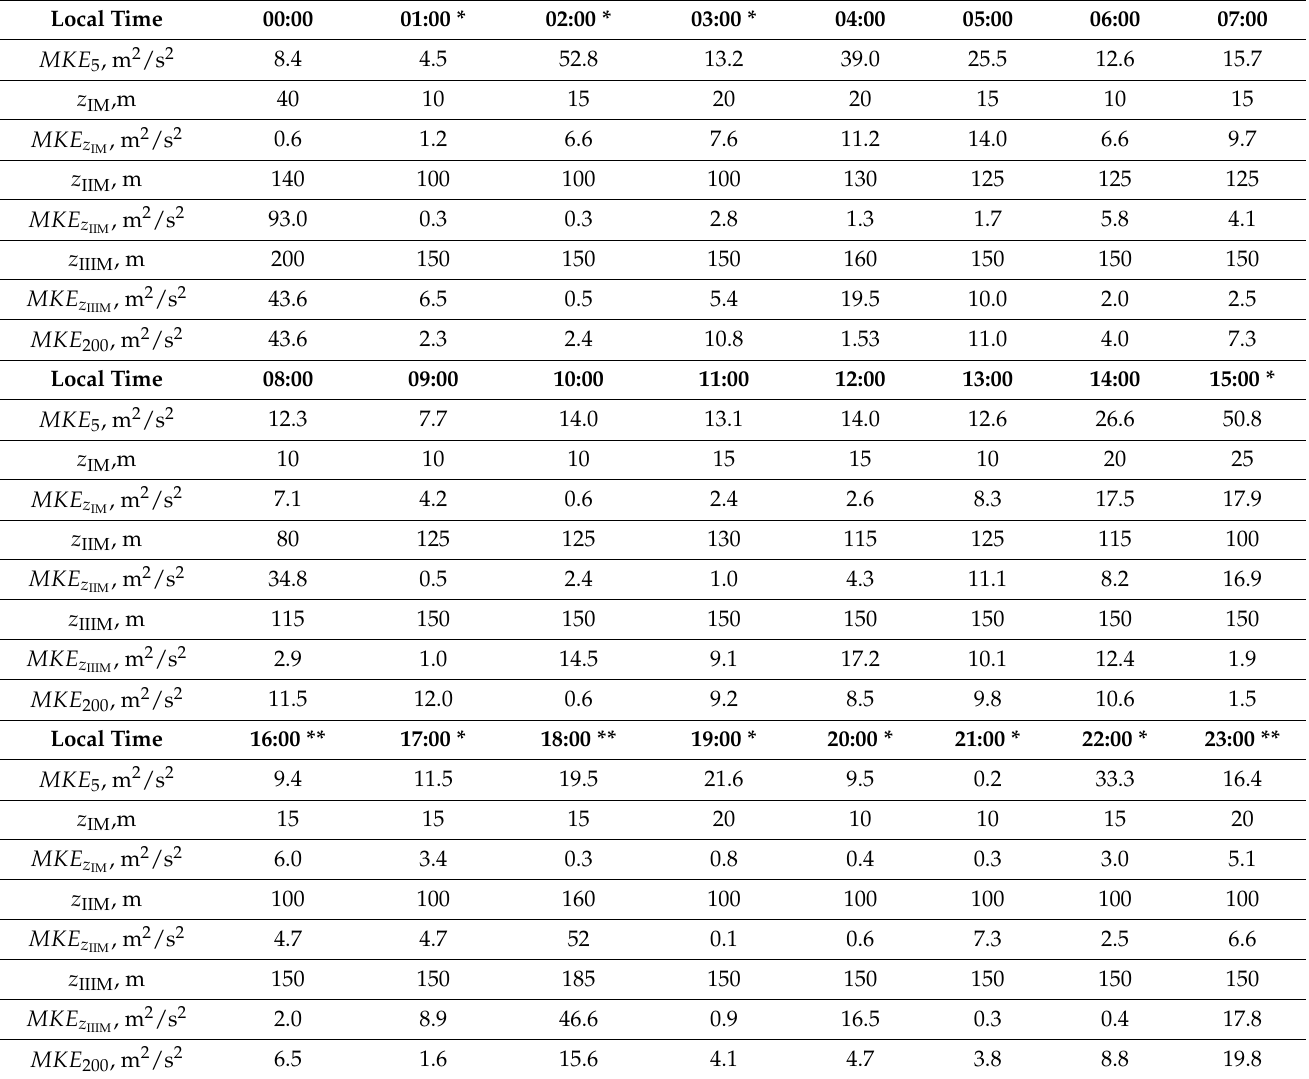
Table 2. Diurnal hourly variations of the altitudes of the three upper layer boundaries and the MKE values at these altitudes. Altitude profiles comprising only two MKI layers I and IV are marked by *, and those comprising the layers with increased MKE values are marked by